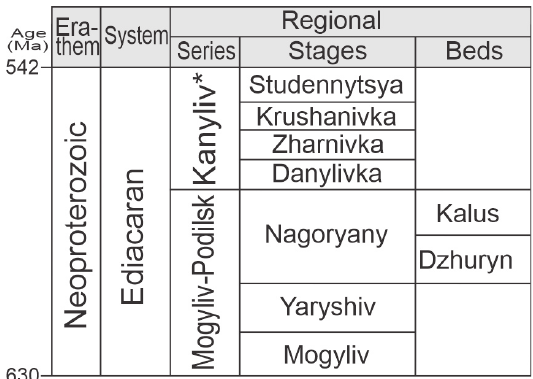
Fig. 5. Stratigraphic scheme of the Ediacaran (Upper Vendian) succession of the Volyn-Podillyan Plate (modified after Velikanov 2011). *According to Paszkowski et al. (2021), the Kanyliv Series is of Lower Cambrian